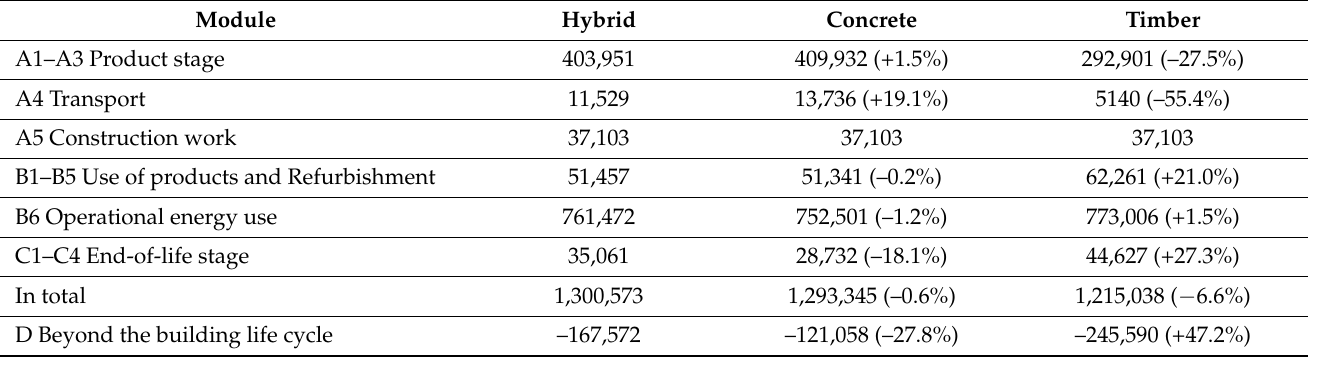
Table 3. Results of carbon footprint comparison (kg CO 2 e) (the percentages in parentheses show the difference from those of the hybrid apartment).